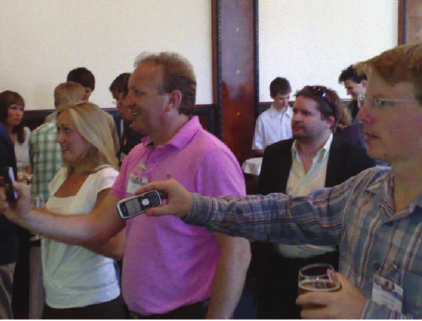
Figure 7: Screenshot of TiltRacer version 1.